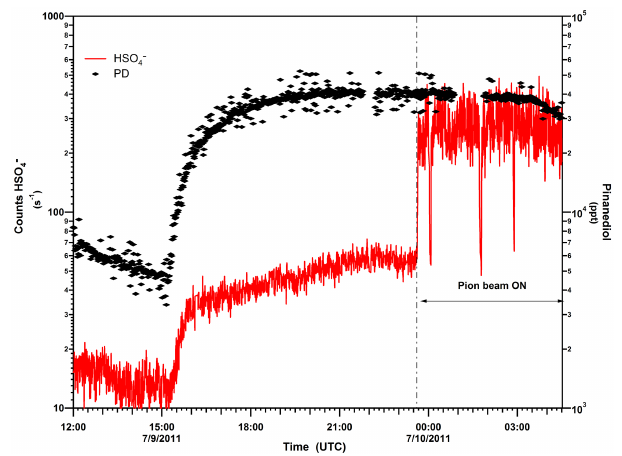
Figure 2. Enhancement of the HSO − count rate in the presence of 4 pinanediol (PD) during an experiment without the presence of UV light. The observed HSO − enhancement in absence of UV light in- 4 dicates the presence of a non-OH oxidant for SO 2 . The change in the PD concentration (factor of ∼ 8) leads to an enhancement (factor of ∼ 5) of the sulfuric acid background concentration (HSO − count 4 rate). For the period shown the SO 2 (3ppbv) and O 3 (50ppbv) mix- ing ratios remained stable; the clearing field high voltage was turned off during the first part of the experiment. The presence of ions gen- erated by the pion beam (23:40UTC and later) increased the CIMS signal by another factor of 5, confirming the ion effect in the pres- ence of